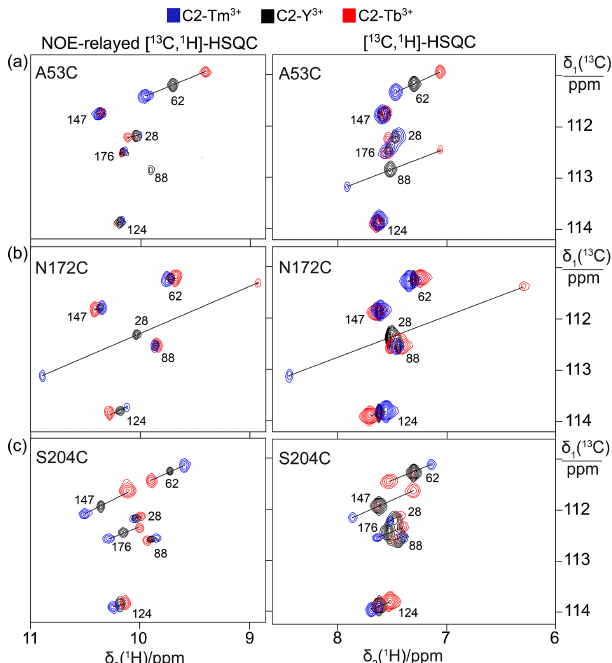
Figure 2. PCSs observed in 13 C- 1 H correlation spectra of 0.4mM solutions of IMP-1 mutants tagged with C2-Ln 3 + tags and con- taining selectively isotope-labelled tryptophan produced from 7- 13 C-indole deuterated in positions 2, 4, 5 and 6. The plots show superimpositions of spectra recorded with diamagnetic (C2-Y 3 + , black) or paramagnetic (C2-Tb 3 + , red; C2-Tm 3 + , blue) tags. All spectra were recorded with spin-state selection in the 13 C dimen- sion to record the narrow low-field component of each 13 C doublet. Right panels: [ 13 C, 1 H]-HSQC spectra. Left panels: NOE-relayed [ 13 C, 1 H]-HSQC spectra (150ms NOE mixing time) to record the H ε 1 resonances of the tryptophan side chains. PCSs are indicated by lines connecting the peaks of paramagnetic and diamagnetic sam- ples. The cross-peaks are labelled with the residue number of the in- dividual tryptophan residues. (a) Mutant A53C. (b) Mutant N172C. (c) Mutant